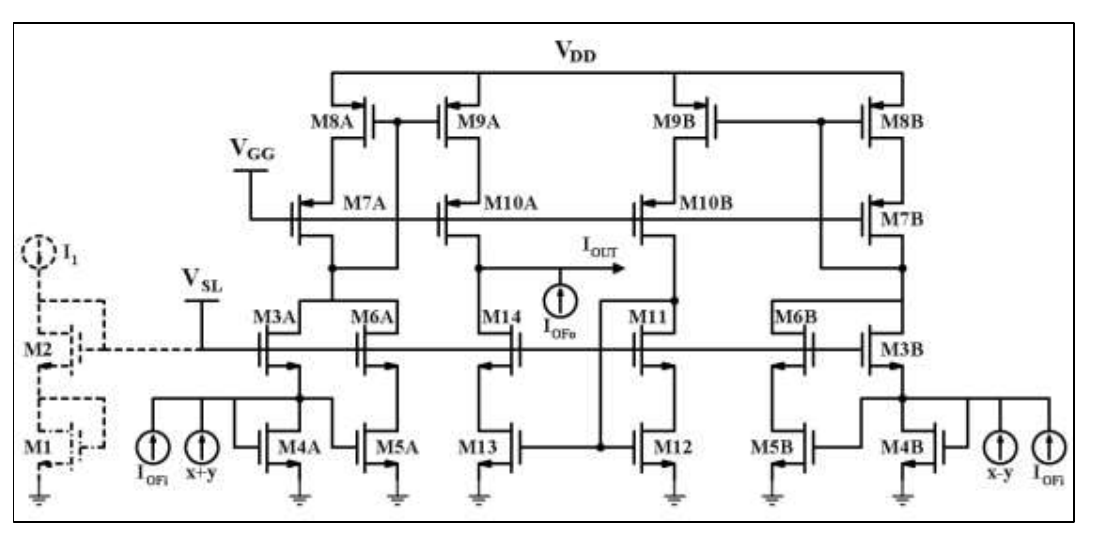
Figure 1. Proposed current-mode analog multiplier